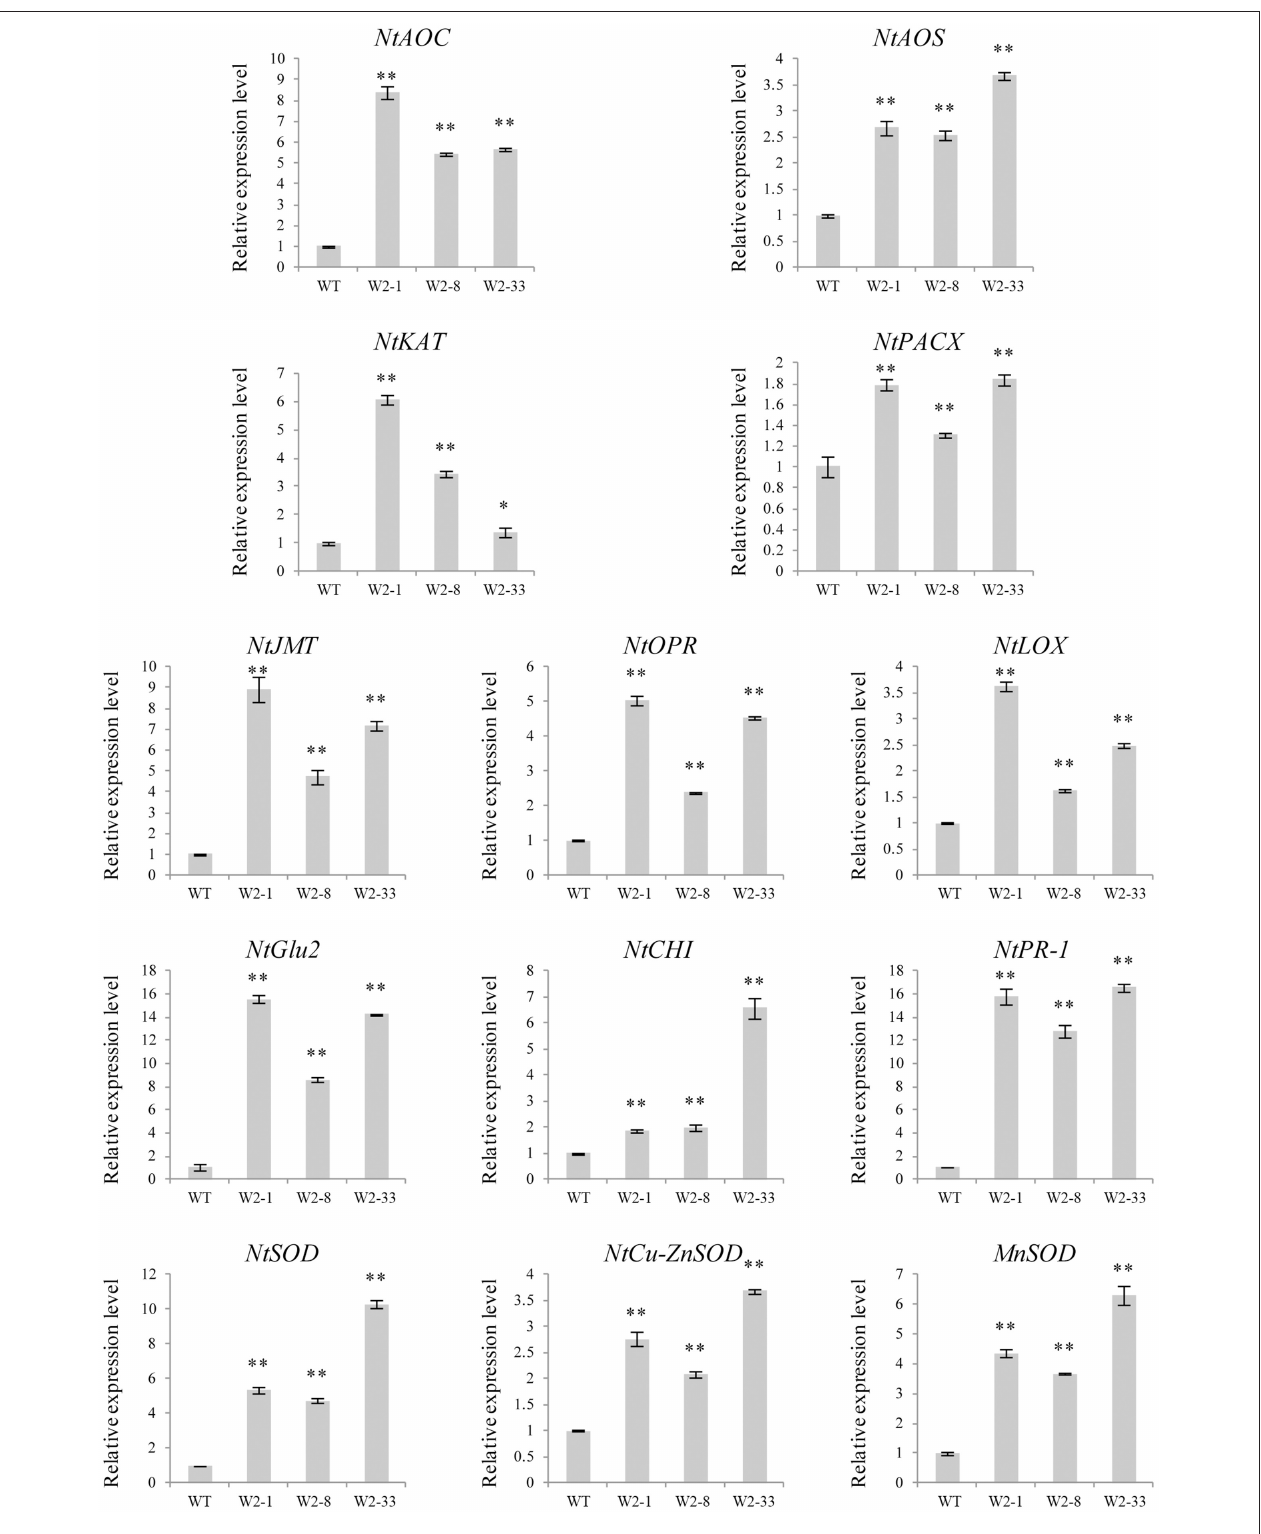
FIGURE 3 | The expression levels of some JA biosynthesis and defense-related genes including the NtAOC , NtAOS , NtKAT , NtPACX , NtJMT , NtOPR , NtLOX , NtCHI , NtGlu2 , NtPR-1 , NtSOD , NtCu-ZnSOD , and MnSOD in the three T2 LrWRKY2 transgenic tobacco lines (W2-1/8/33) were evaluated by qRT-PCR. Bars represent the standard errors of three biological replicates. The results was calculated by the 2 − 11 Ct method and analyzed by the t test (* p < 0.05, ** p < 0.01).